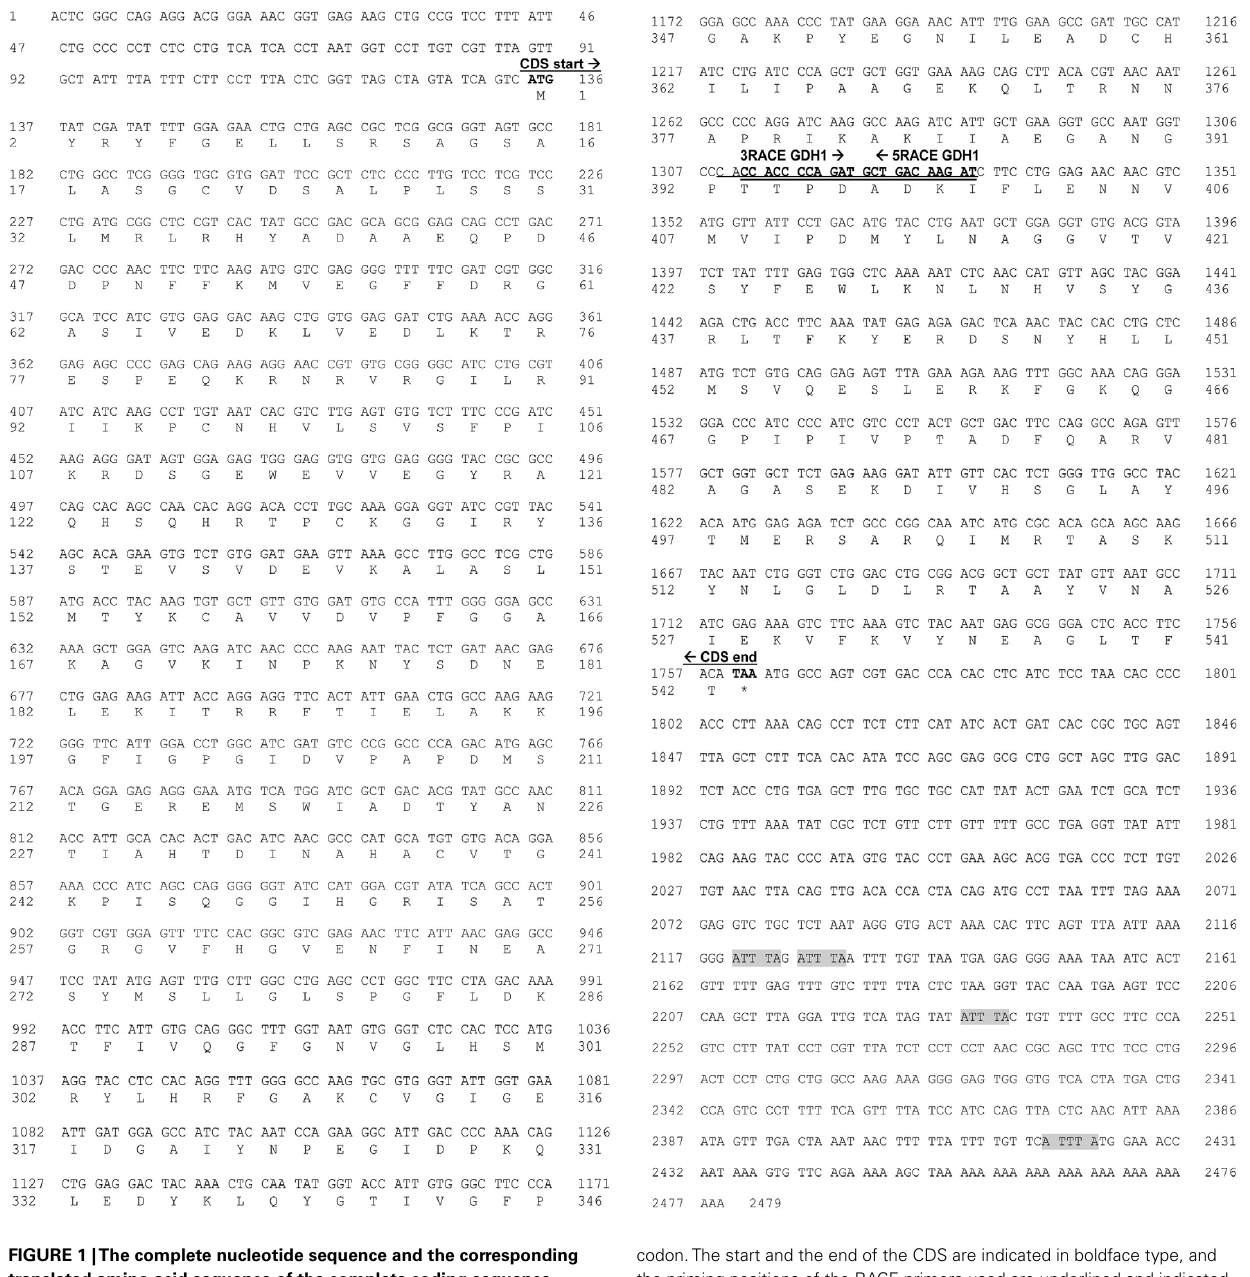
FIGURE 1 |The complete nucleotide sequence and the corresponding translated amino acid sequence of the complete coding sequence (CDS)of glutamate dehydrogenase 1a (gdh1a; GenBank accession no. JF694445) from the liver of Monopterus albus . “ ∗ ” Indicates the stop